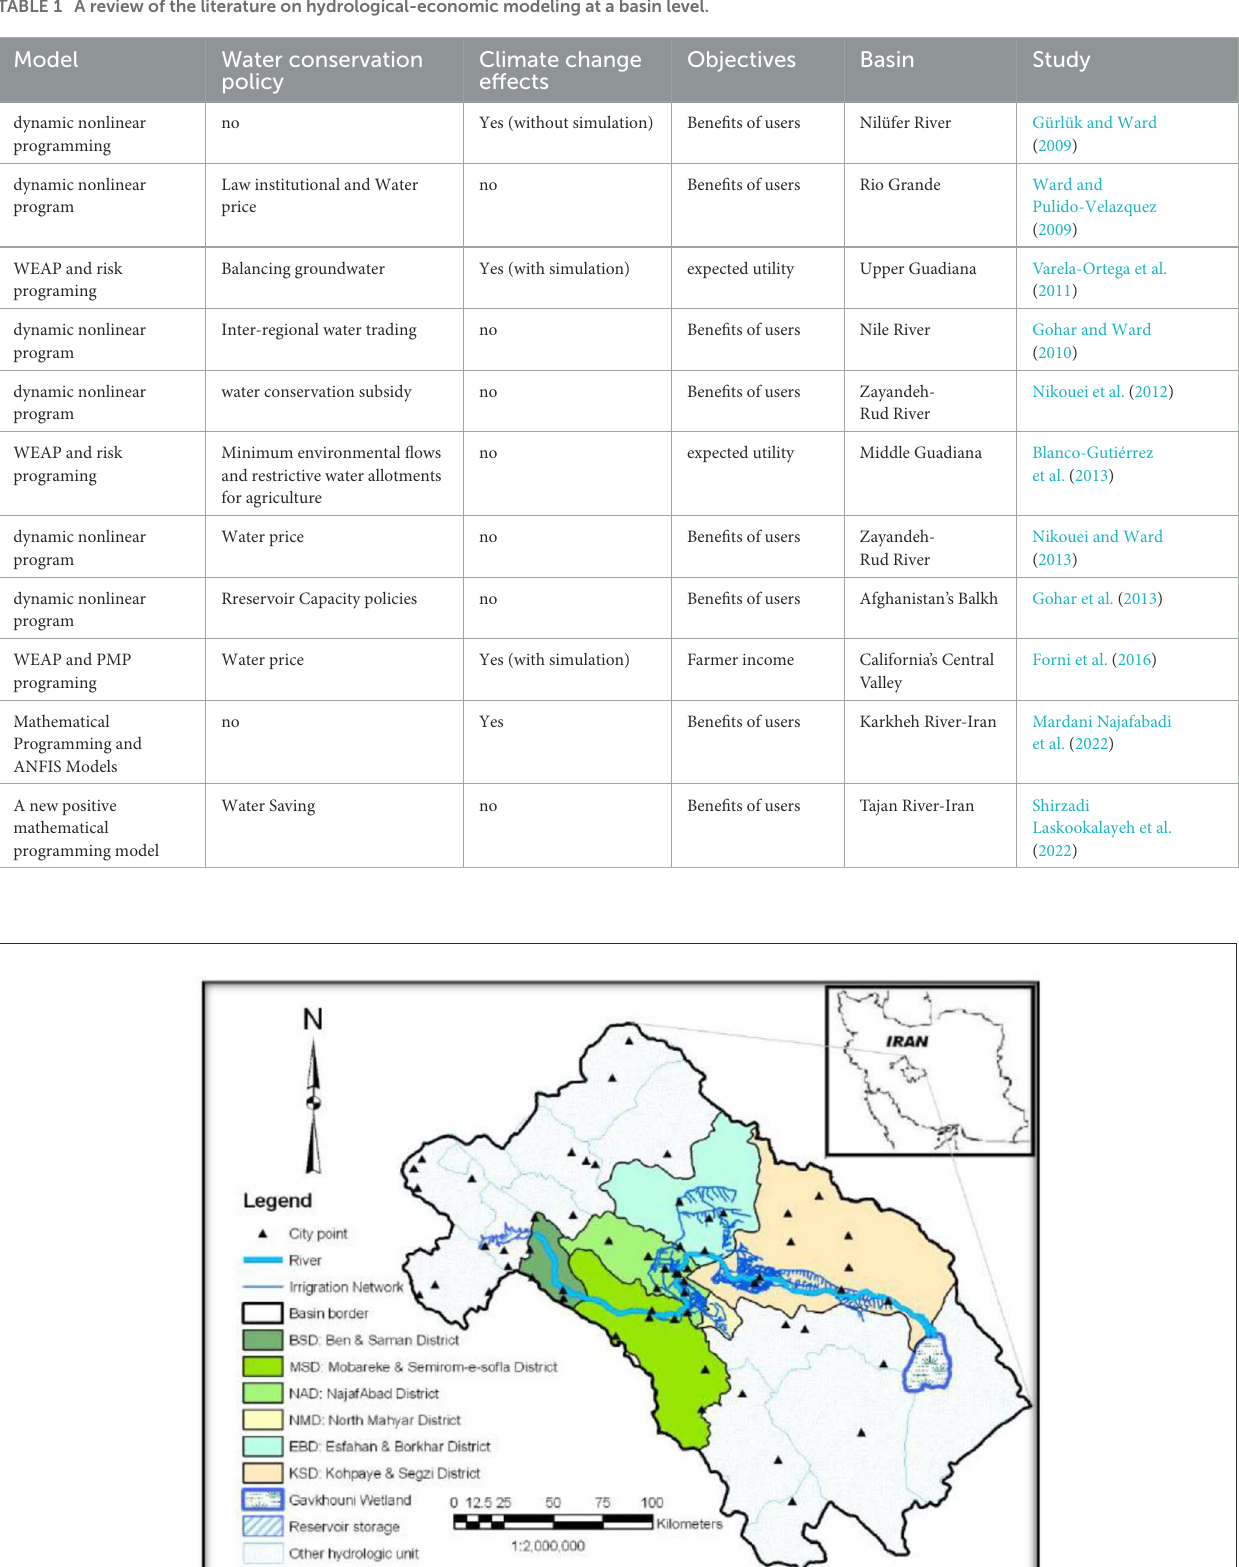
TABLE 1 A review of the literature on hydrological-economic modeling at a basin level.